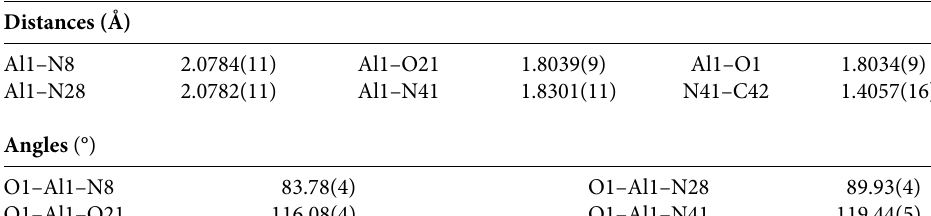
Table 3. Selected interatomic distances and angles of 3